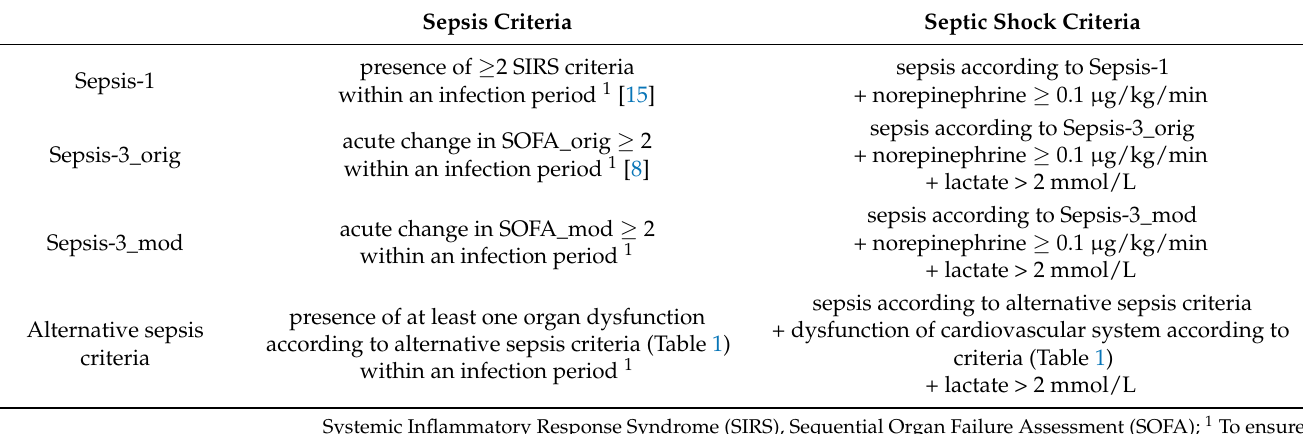
Table 2. Criteria to diagnose sepsis and respective septic